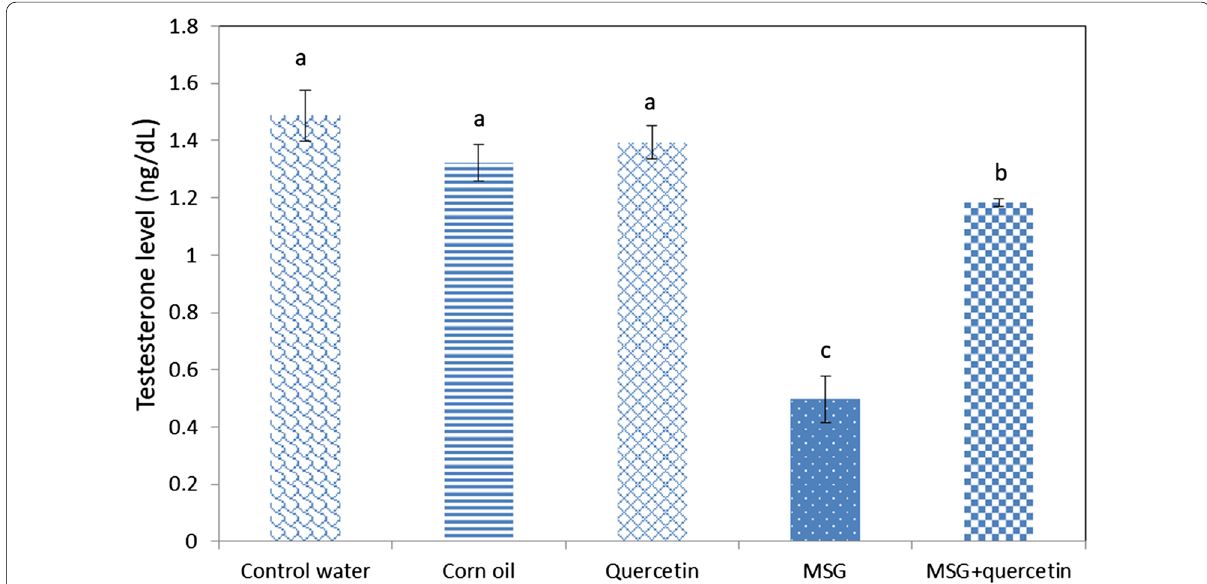
Fig. 5 Effect of quercetin on testosterone level (ng/dl) of MSG‑intoxicated male rats. The number of samples in each group is six. Values were expressed as mean standard error. Means which share different superscript symbol(s) are significantly different at p < ±